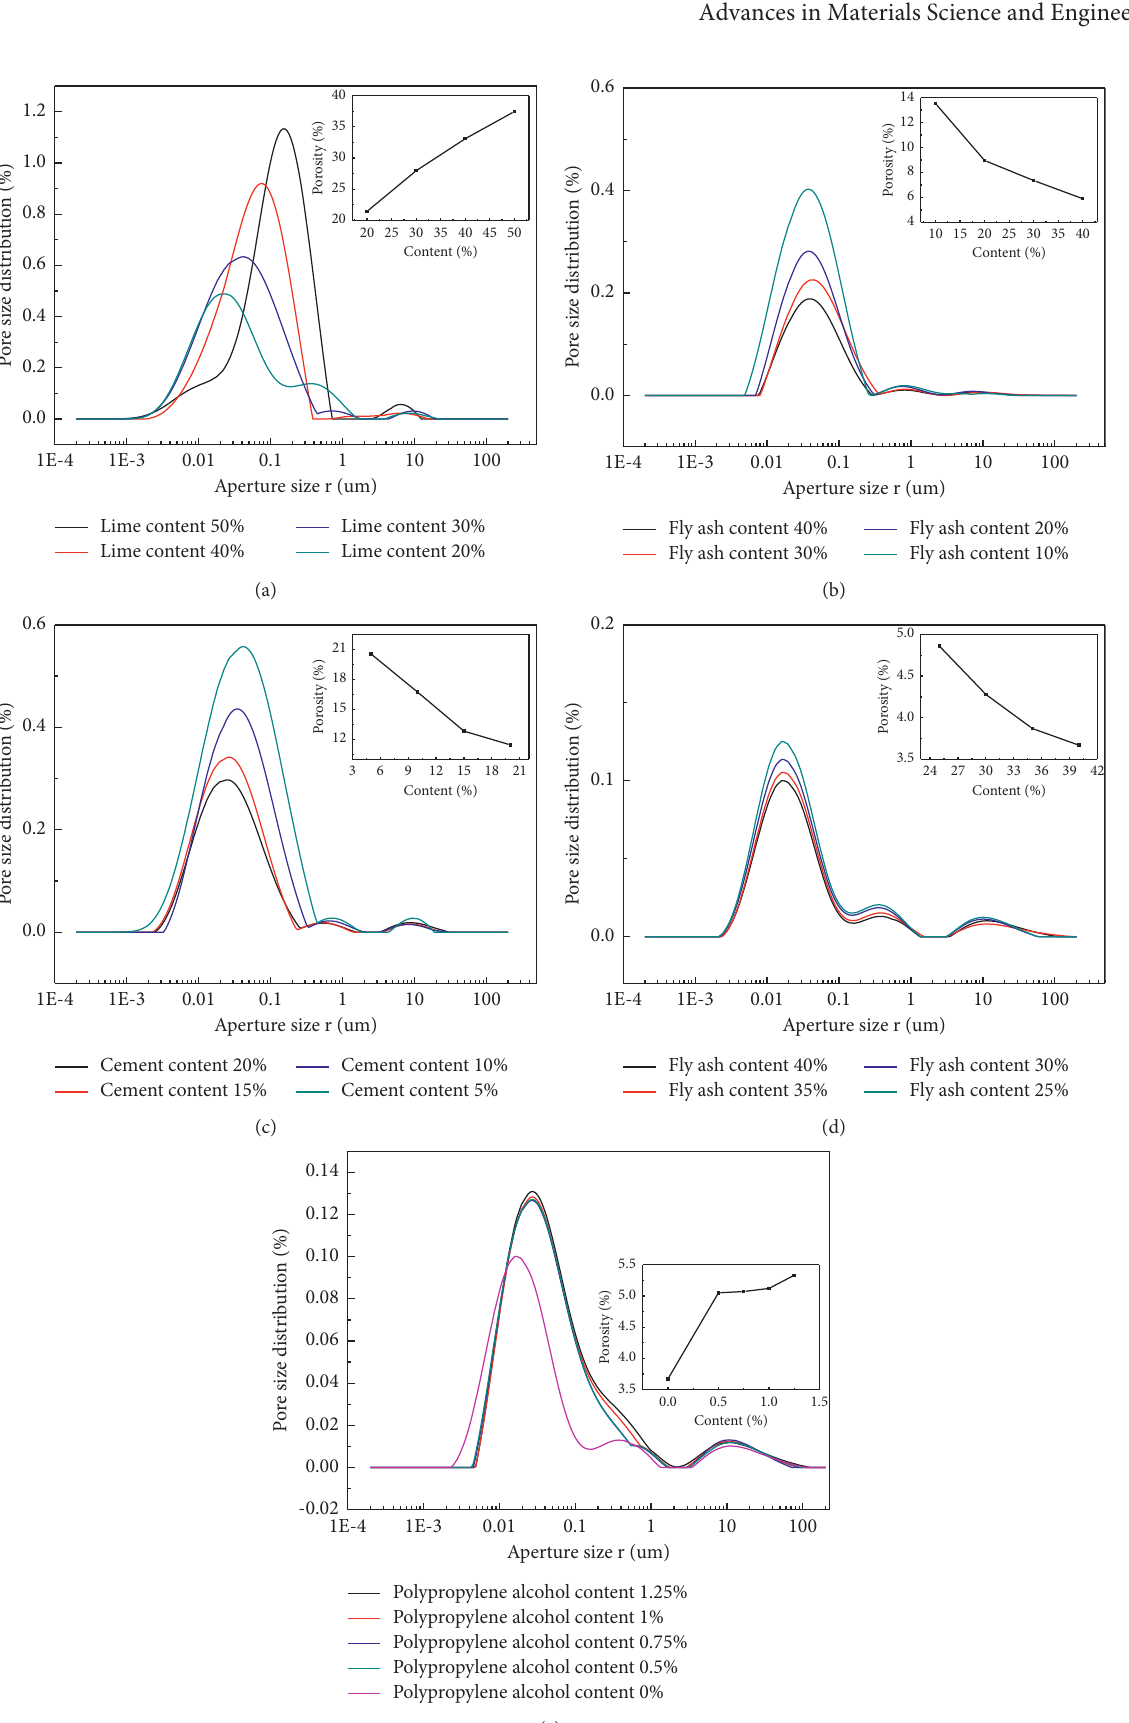
Figure 8: The influence of different content of lime (a), fly ash (lime 30%) (b), cement (lime 30%) (c), fly ash (lime 10%, cement 5%) (d), and polyvinyl alcohol (lime 10%, cement 5%, fly ash 40%) (e) on the pore size distribution and